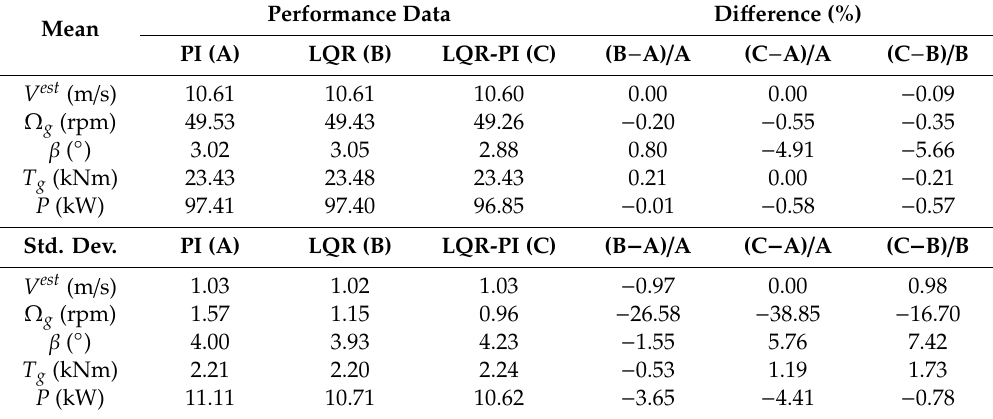
Table 3. Quantitative comparison of performance data in the rated power region without noise.